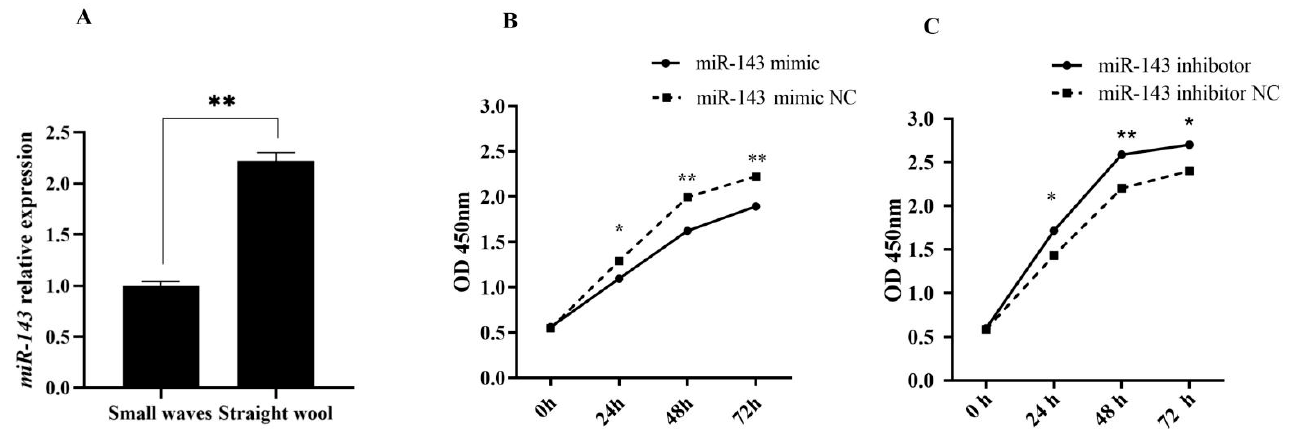
Figure 1. The expression level of miR-143 ( A ) in small waves and straight wool, the CCK-8 results ( B ) after transfection of the miR-143 mimic and NC, and the CCK-8 results ( C ) after transfection of the miR-143 inhibotor and NC. * p < 0.05 or ** p < 0.01.